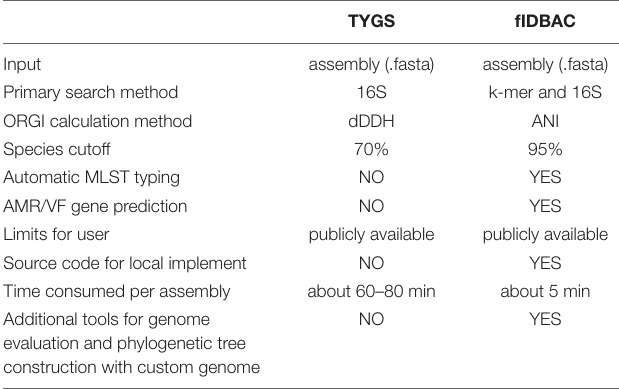
TABLE 2 | An overview of the features of fIDBAC compared to the TYGS web server.